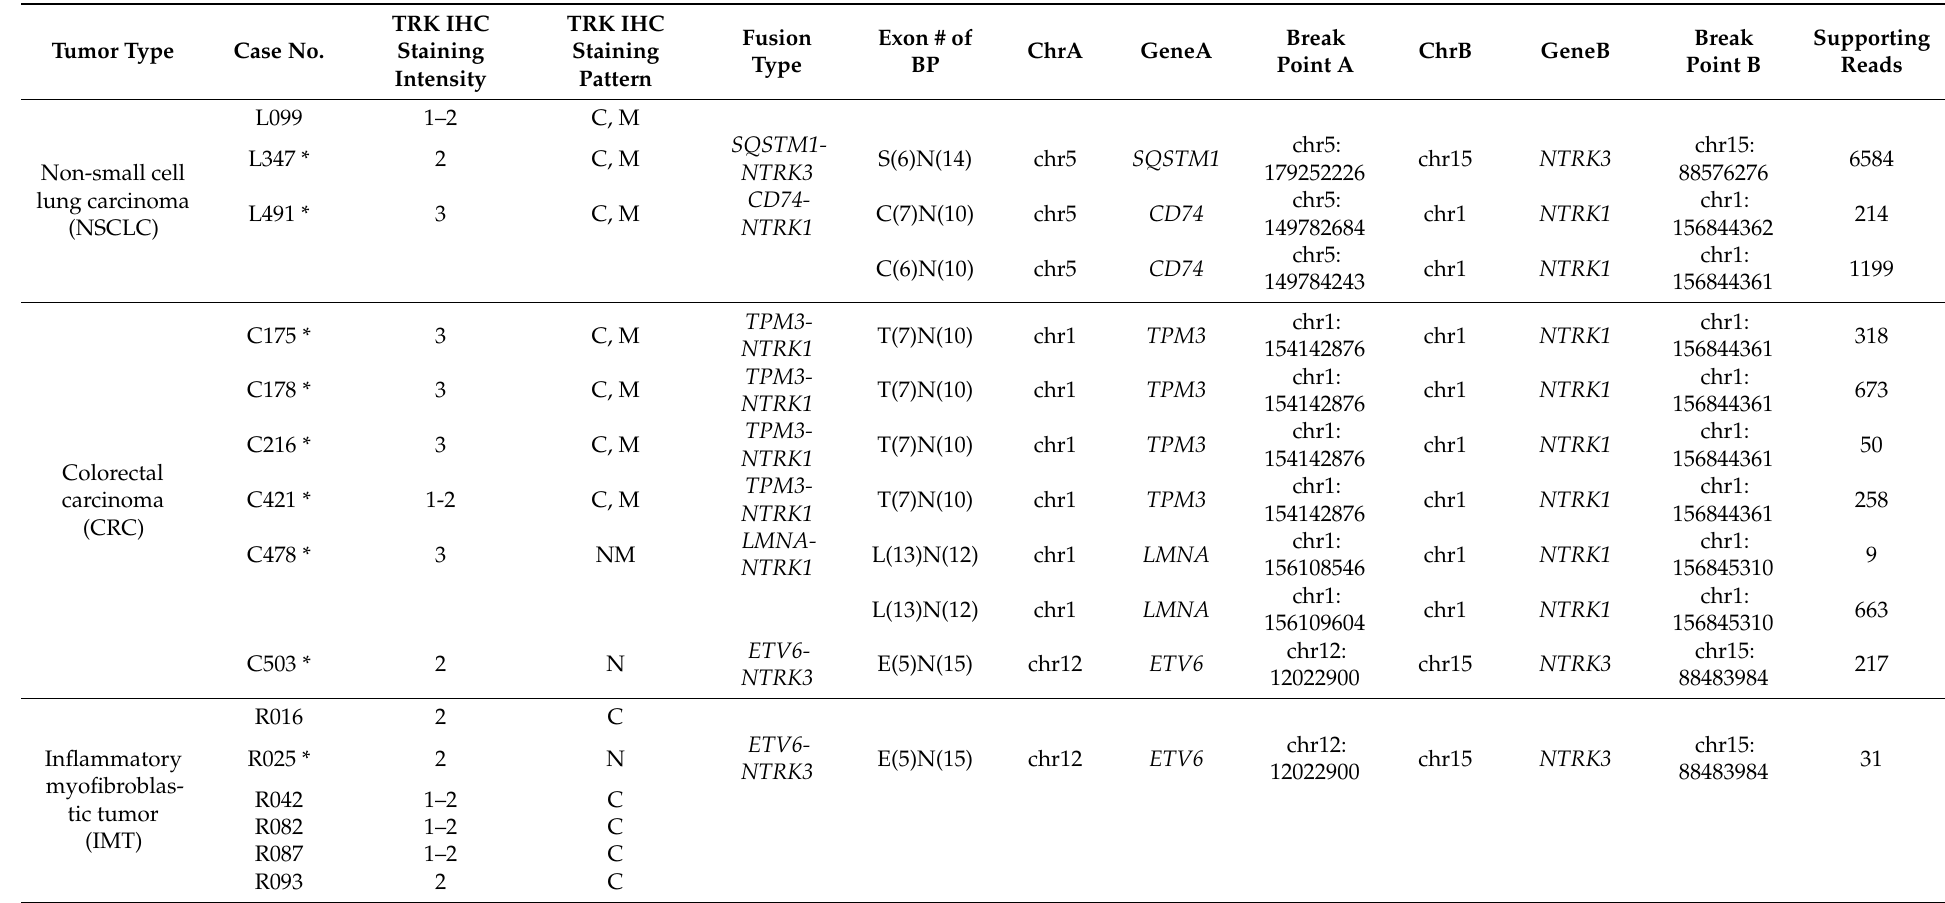
Table 2. Pan-Trk immunohistochemical and molecular characteristic of 15 TRK expression